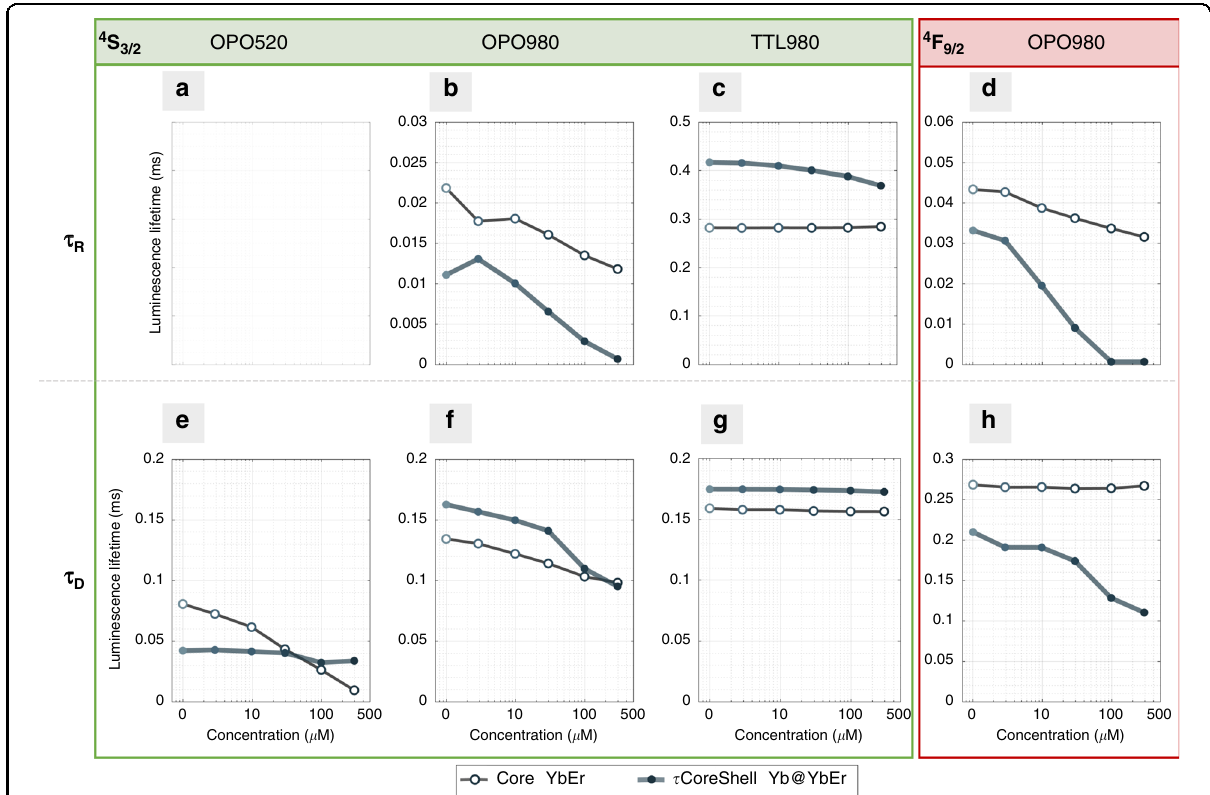
Fig. 4 Quantitative comparison of luminescence rise and decay times of YbEr and Yb@YbEr samples undergoing UC-LRET. Luminescence rise and decay times for energy levels. 4 S 3/2 (525 – 550 nm) ( a – c , e – g ) and 4 F 9/2 (650 nm) ( d , h ) emission from (open symbol) YbEr core only and (solid symbol) Yb@YbEr core-shell UCNPs respectively, at a rising concentration of Rose Bengal attached to their surface. Various excitation modes were compared: a , e 520 nm 10 ns pulse from OPO laser; b , f 980 nm 10 ns pulse from OPO laser; c , g 980 nm 4 ms pulse from TTL-triggered 10 W CW laser diode. The luminescence rise times ( τ R ) ( a – d ) and averaged decay ( τ D ) ( e – h ) components are shown